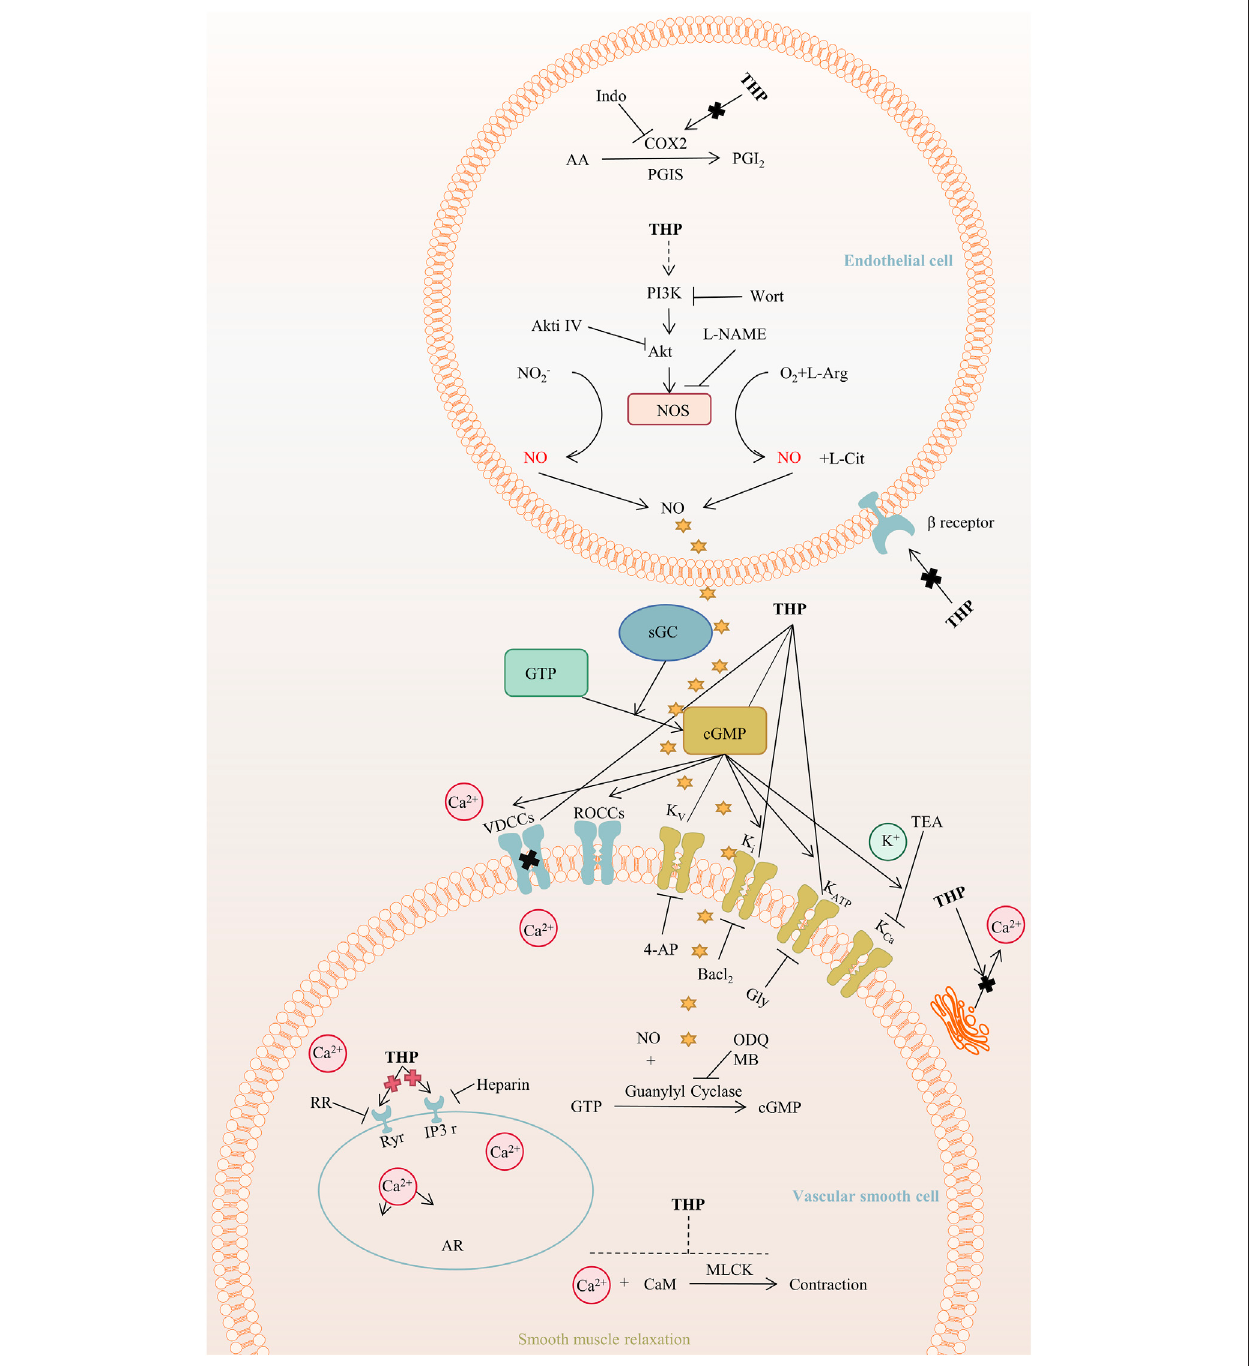
FIGURE6| ThemaintargetsandpathwaysofvasodilatoryactivityofTHP.Abbreviations:THP,Tetrahydropalmatine;Indo,Indomethacin;COX2,Cyclooxygenase- 2; PGI 2 , Prostacyclin; PGIS, Prostacyclin synthase; AA, Arachidonic acid; PI3K, Phosphatidylinositol 3-kinase; Wort, Wortmannin; Akt, Protein kinase B; Akti Ⅳ , Akt inhibitor Ⅳ ; L-NAME, L-nitroarginiemethylester; NOS, Nitric oxide synthase; L-Arg, L-arginine; NO, Nitric oxide; L-Cit, L-Citrulline; GTP, Guanosine triphosphate; sGC, Soluble guanylyl cyclase; cGMP, Cyclic guanosine monophosphate; VDCCs, Voltage-dependent calcium channels; ROCCs, Receptor-operated calcium channels; K v , Voltage-dependent potassium channel; K i , Inward rectifying potassium channel; K ATP , ATP-sensitive potassium channel; K Ca , Calcium-activated potassium channel; TEA, Tetraethylammonium; 4-AP, 4-Aminopyridine; Gly, Glibenclamide; ODQ, 1H-[1,2,4]-oxadiazolo-[4,3-alpha]-quinoxalin-1-one; MB, Methylene blue; RR, Ruthenium red; Ryr, Ryanodine receptors; IP3r, IP3 receptors; AR, Aorta relaxation; CaM, Calmodulin; MLCK, Myosin light chain kinase.